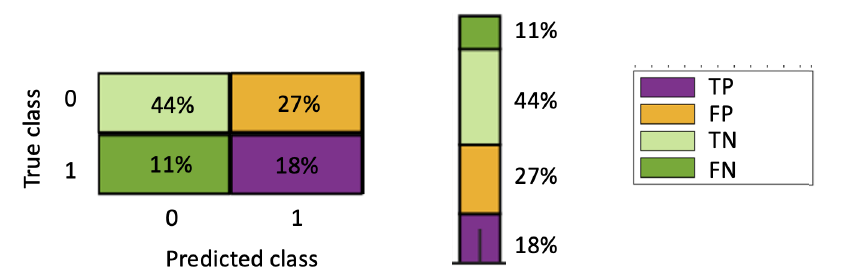
Figure 3. Representative example of the confusion matrix with bar shapes, used for the joint repre- sentation of all users’ data. The sections in the vector are proportional to the percentage of the cell corresponding to the confusion matrix. The height of the bar will be proportional to the number of interactions made by the subject. Note the colour coding to represent the TP (True Positives), the FP (False Positives), the TN (True Negatives) and the FN (False